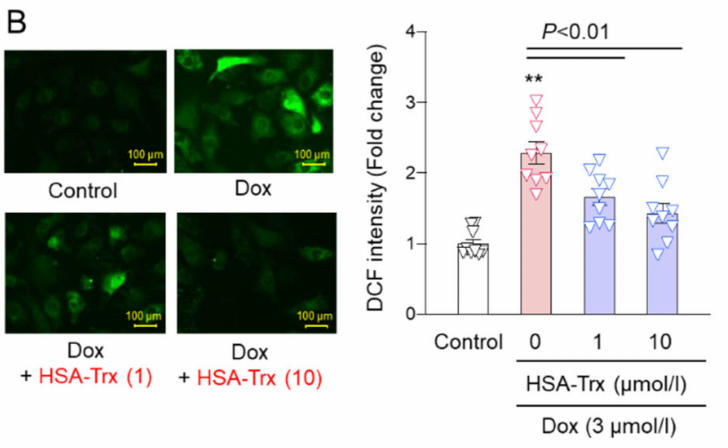
Figure 4. Effect of HSA-Trx on cell shrinkage and cellular ROS level in Dox-treated NRCMs: ( A ) Dox- induced cell shrinkage was determined by phalloidin staining in NRCMs. The phalloidin fluorescence was excited by illumination at 488 nm and then observed at room temperature using a confocal laser microscopy. NRCMs were also treated with DAPI (blue). Original magnification: × 25. Scale bar represents 100 mm. ( B ) Production of ROS in NRCMs was measured using CM-H 2 DCFDA, an ROS-sensitive fluorescent dye. Image analysis was performed to quantify the extent and intensity of DCF staining. Original magnification: × 10. Scale bar represents 100 µ m. Results are the means ± S.E. ( n = 9). ** p < 0.01 compared with